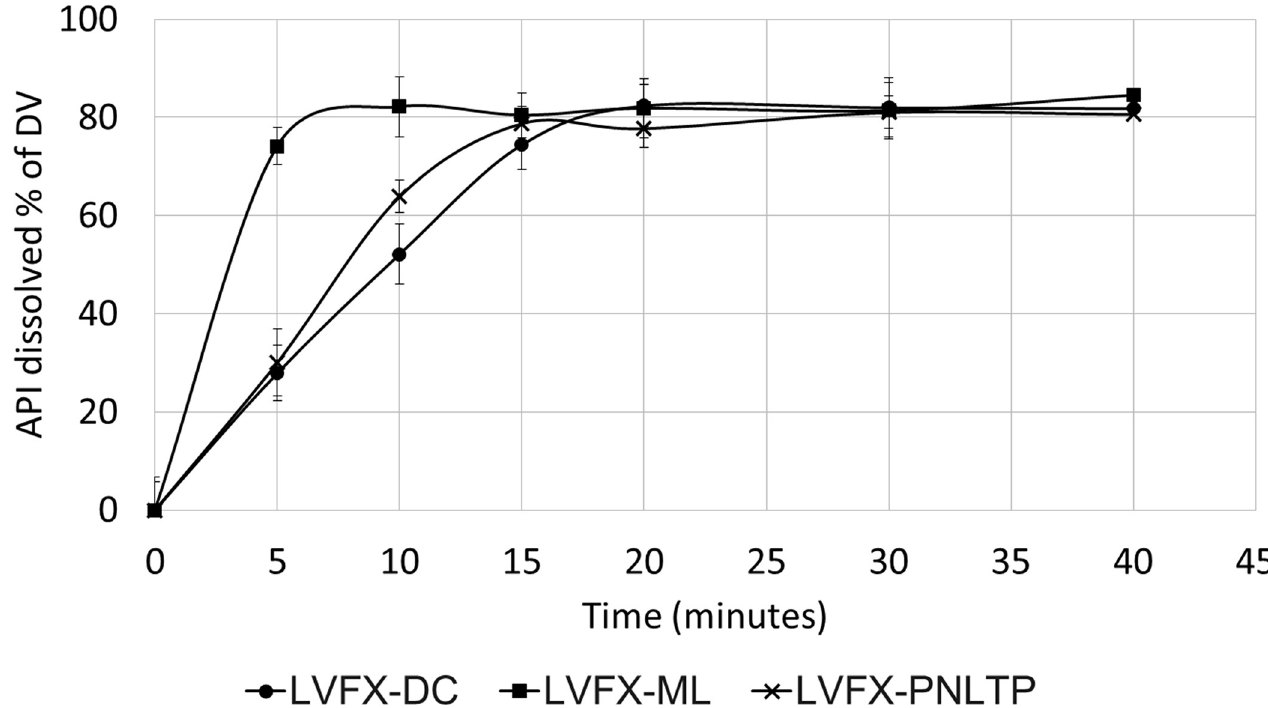
Fig 2. Dissolution profiles of levofloxacin drug products. LVFX-DC: Tavanic 1 . LVFX-ML: Levofloxacino Cinfa 1 . LVFX-PNLTP: Amesol 1 . API: Active pharmaceutical ingredient. DV: Declared value.